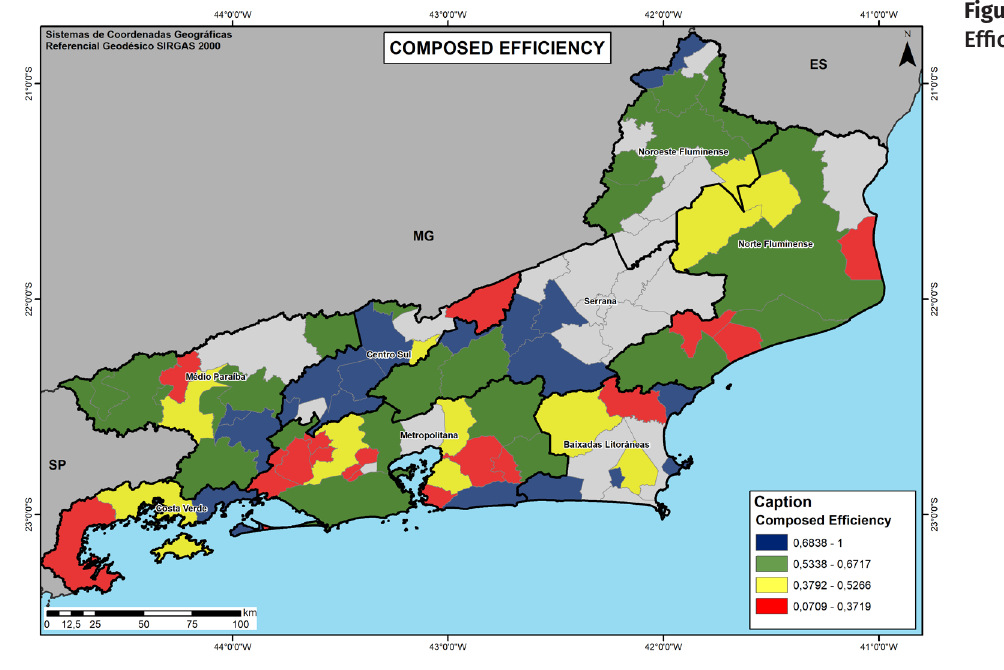
Figure 1. Composed Efficiency